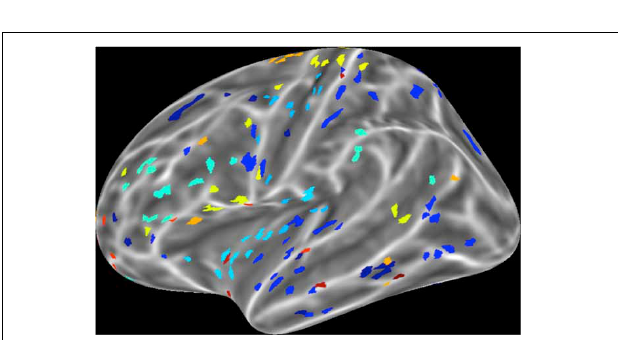
FIGURE 3 | An example of interacting cortical sites for 10 randomly selected seeds in the model. Each color indicates a set of 16 sites that interact with the same seed. Interacting sites are chosen based on the 16 highest correlation coefficients of each seed in the all pair-wise correlation